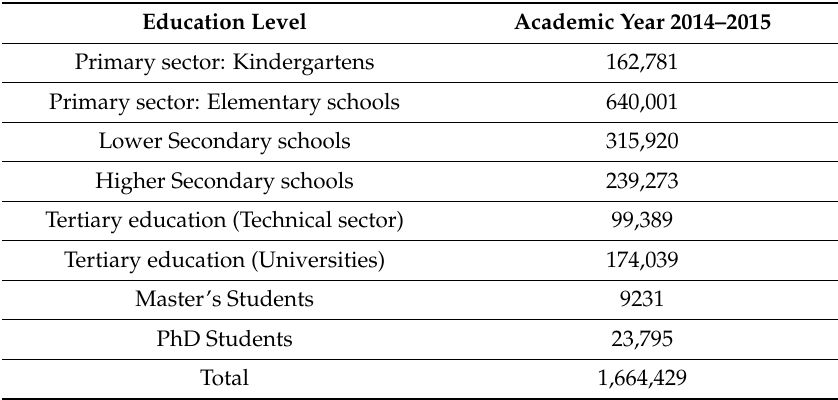
Table 1. Number of pupils and students in all Greek education levels (Source: The Hellenic Statistical Authority (ELSTAT)) through the quarterly publication Greece in figures of